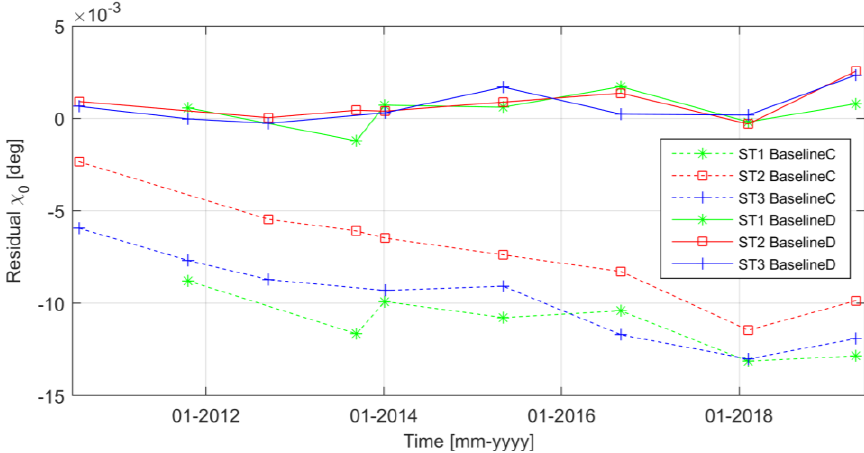
Figure 7. Residual roll bias from Baseline-C and Baseline-D acquisitions.